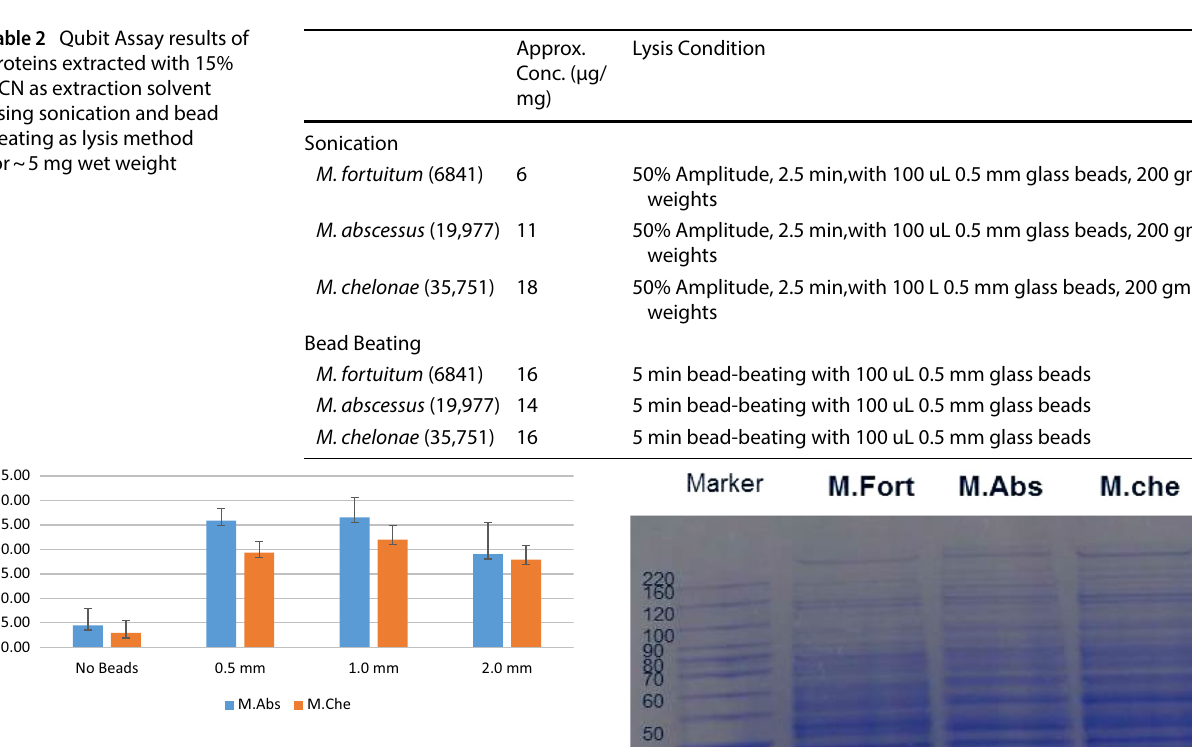
Fig. 2 Plot of amount of proteins extract (µg/mg) vs glass bead size used for sonication lysis method with GuHCl as extraction solvents. Abs = M. abscessus , Che = M. chelonae